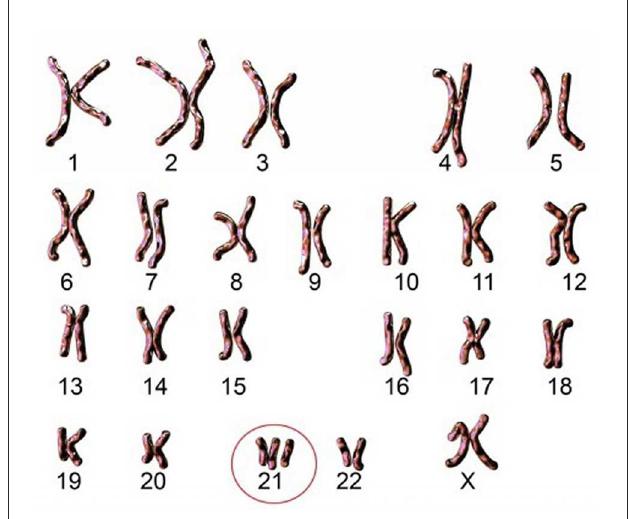
FIGURE1 Karyotype of an individual with free and homogeneous trisomy. Source: Imago/Science Photo